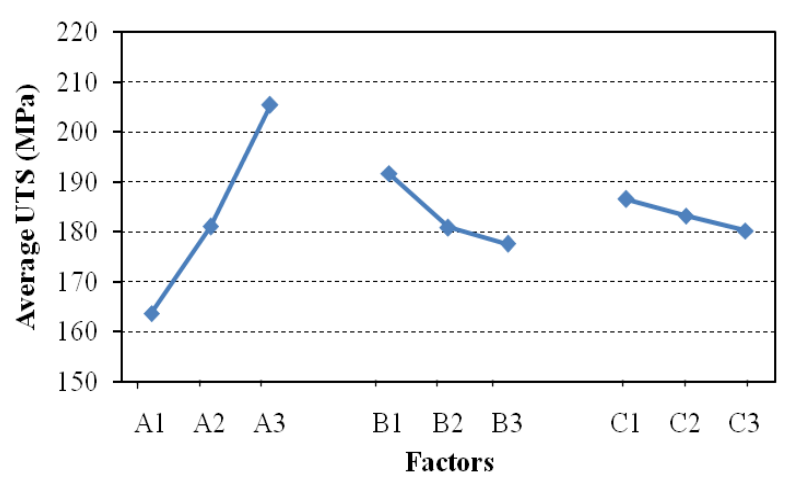
Figure 2. Main effects graph for